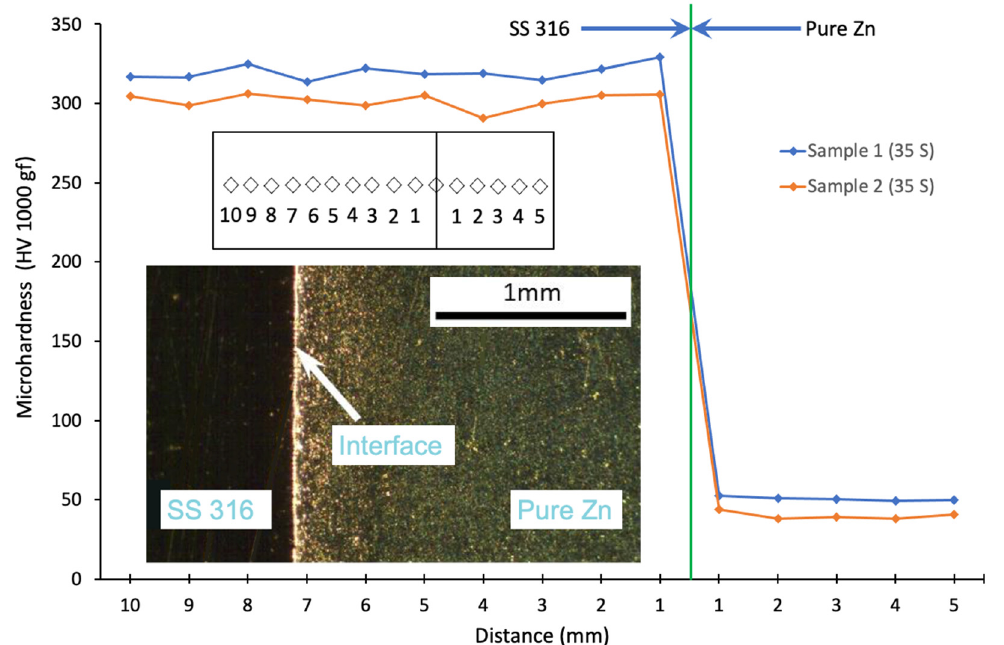
Figure 7. Hardness distribution across the weld of SS 316-pure Zn from two samples with friction time of 35 s.